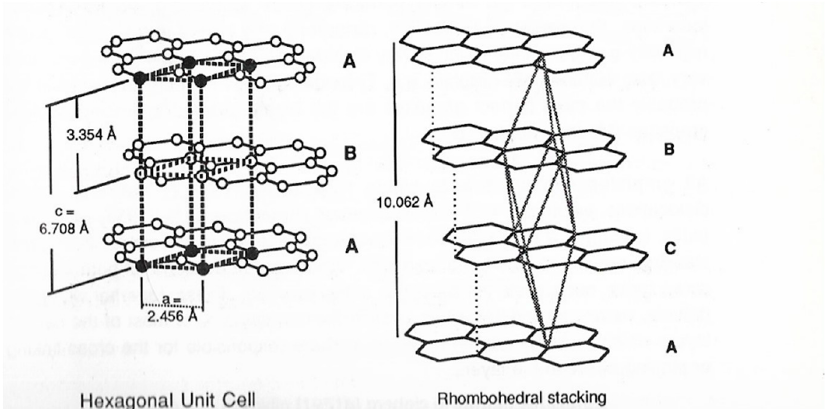
Figure 3. Graphite structure. Figure 3. Graphite